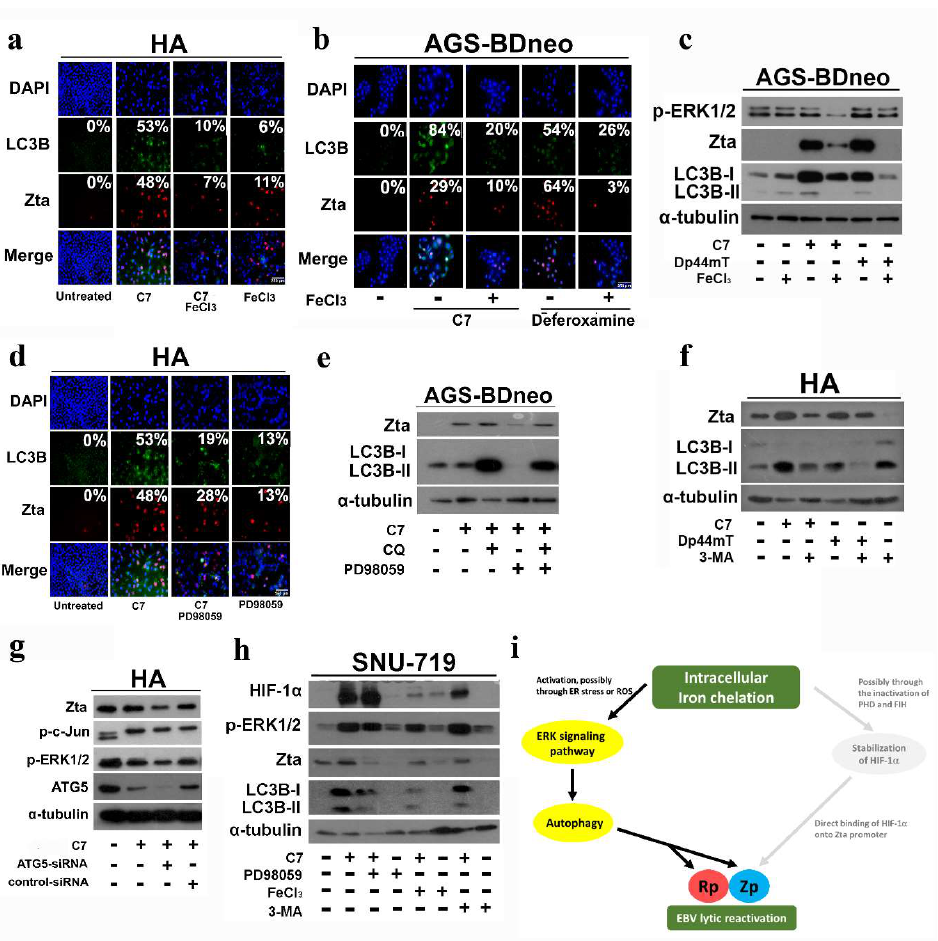
Figure 5. C7 and iron chelators reactivate EBV lytic cycle via intracellular iron chelation and activation of the ERK-autophagy axis. ( a ) HA cells were incubated with either 20 µ M C7 or 20 µ M iron-precomplexed C7 for 48 h. Expression of Zta (red signals) and LC3B (green signals) was analyzed by immunofluorescence staining. DAPI (blue signals) stained cell nuclei. Scale Bar: 250 µ m. ( b ) AGS-BDneo cells were incubated with either 20 µ M C7, 20 µ M iron-precomplexed C7, 1000 µ M deferoxamine, or 1000 µ M iron-precomplexed deferoxamine for 48 h. Expression of Zta (red signals) and LC3B (green signals) was analyzed by immunofluorescent staining. DAPI (blue signals) stained cell nuclei. Scale Bar: 250 µ m. ( c ) AGS-BDneo cells were treated with either 20 µ M C7, 20 µ M iron-precomplexed C7, 20 µ M Dp44mT, or 20 µ M iron-precomplexed Dp44mT for 48 h. The expression of Zta and LC3B was analyzed by Western blotting. ( d ) HA cells were incubated with either 20 µ M C7 or 20 µ M C7 in combination with 50 µ M PD98059 (MEK inhibitor) for 48 h. Expression of Zta (red signals) and LC3B (green signals) was analyzed by immunofluorescent staining. DAPI (blue signals) stained cell nuclei. Scale Bar: 250 µ m. ( e ) AGS-BDneo cells were treated with either 20 µ M C7, 20 µ M C7 in combination with 10 µ M chloroquine, 20 µ M C7 in combination with 50 µ M PD98059 (MEK inhibitor), 20 µ M C7 in combination with 50 µ M PD98059 (MEK inhibitor), or 10 µ M chloroquine for 48 h. The expression of Zta and LC3B was analyzed by Western blotting. ( f ) HA cells were treated with either 20 µ M C7, 20 µ M C7 in combination with 5mM 3-MA, or 20 µ M Dp44mT or 20 µ M Dp44mT in combination with 5 mM 3-MA for 48 h. The expression of Zta and LC3B was analyzed by Western blotting. ( g ) Wild-type, atg5 knockdown and scramble control knockdown HA cells were treated with 20 µ M C7 for 48 h. The expression of phosphorylated-c-Jun, phosphorylated-ERK1/2, ATG5, and Zta was analyzed by Western blotting. ( h ) SNU-719 cells were treated with either 20 µ M C7, 20 µ M C7 in combination with 50 µ M PD98059, 50 µ M PD98059 alone, 20 µ M iron-precomplexed C7, 20 µ M C7 in combination with 3-MA, or 3-MA alone for 48 h. The expression of HIF-1 α , p-ERK1/2, Zta, and LC3B was analyzed by Western blotting. ( i ) Schematic illustration of EBV lytic reactivation via the proposed intracellular iron chelation-ERK-autophagy